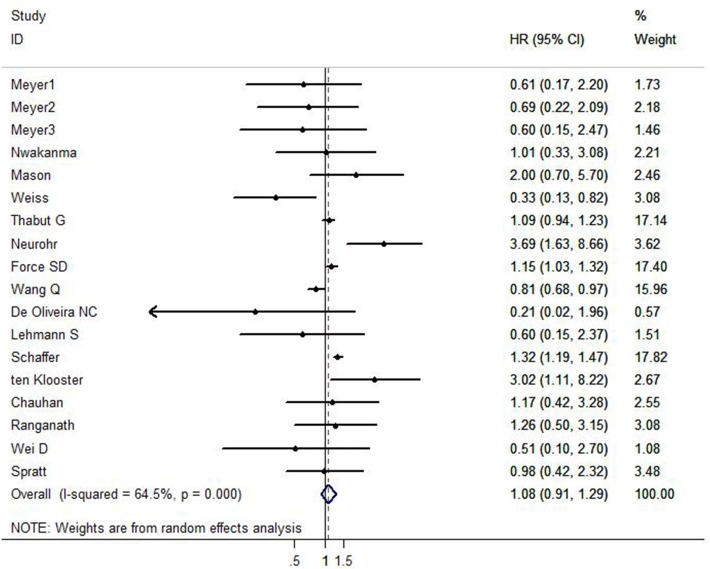
Overall survival between recipients undergoing DLT versus SLT stratified by HR estimation.The summary HR and 95% CIs were shown (according to the random effect estimations).